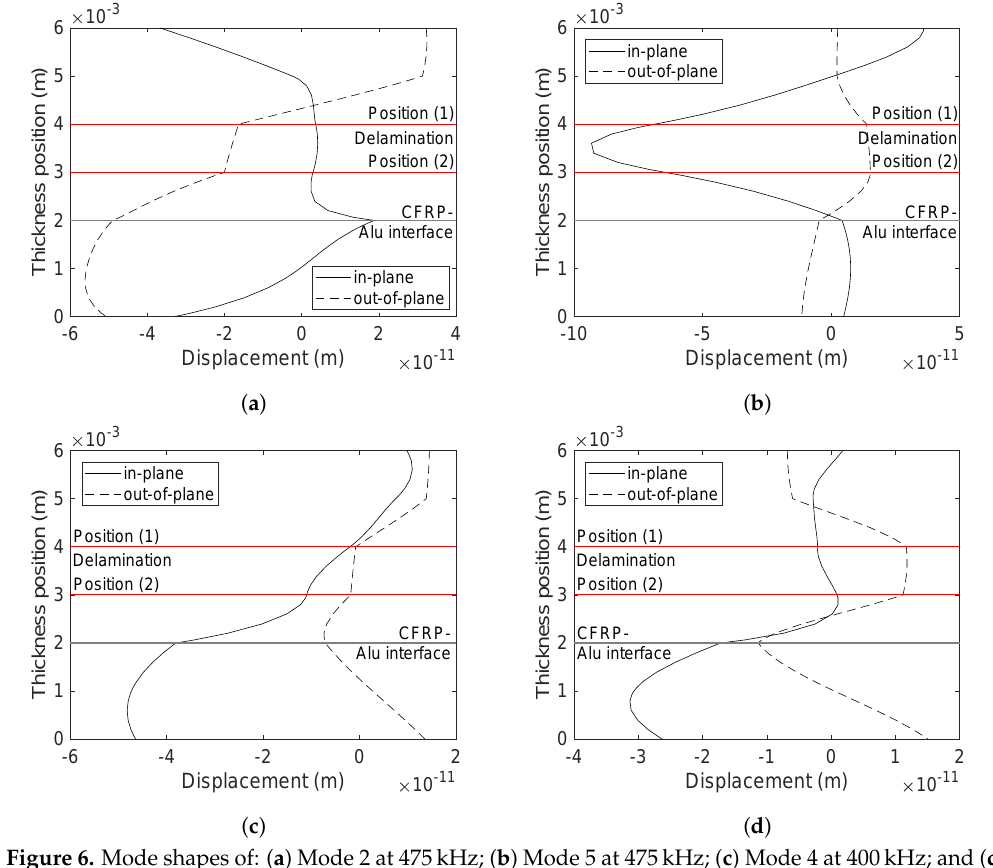
Figure 6. Mode shapes of: ( a ) Mode 2 at 475kHz; ( b ) Mode 5 at 475kHz; ( c ) Mode 4 at 400kHz; and ( d ) Mode 6 at 700kHz. Red lines mark delamination placed between the second and the third ply (Position (1)), and the third and the fourth ply (Position (2)) (counted from top to